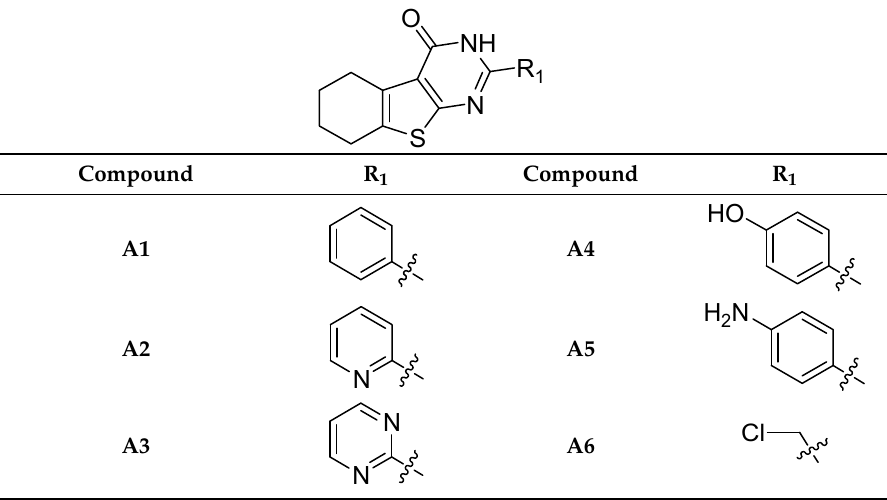
Table 1. Chemical Structures of Target Compounds A1 – 6 .